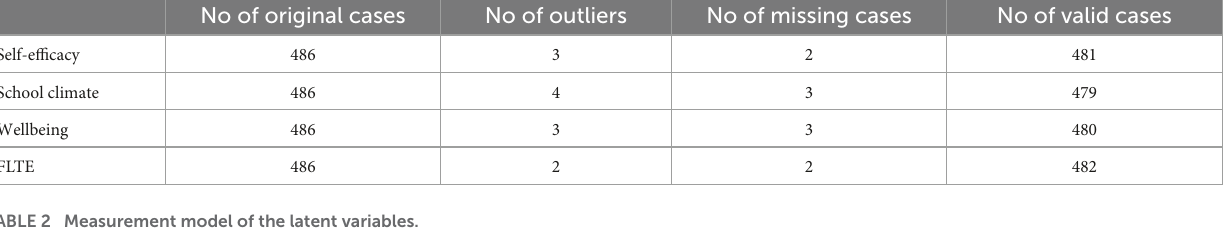
TABLE 2 Measurement model of the latent variables.